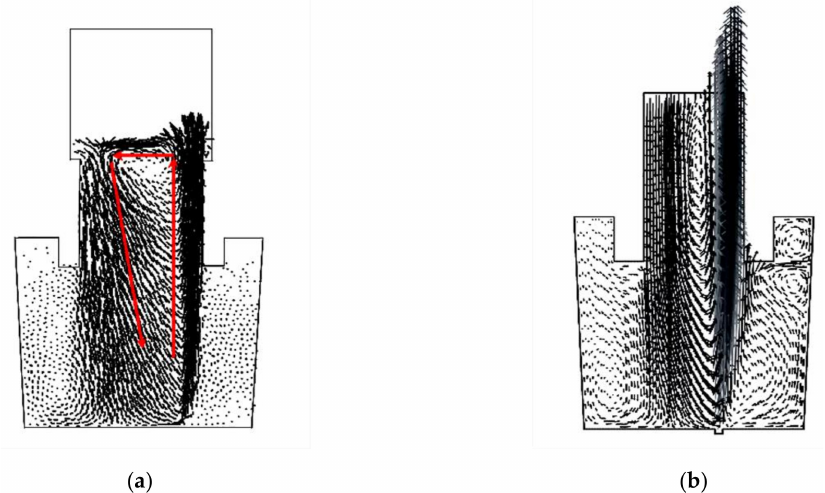
Figure 9. Comparison of the flow field based on different model ( a ) present model; ( b ) Yang’s